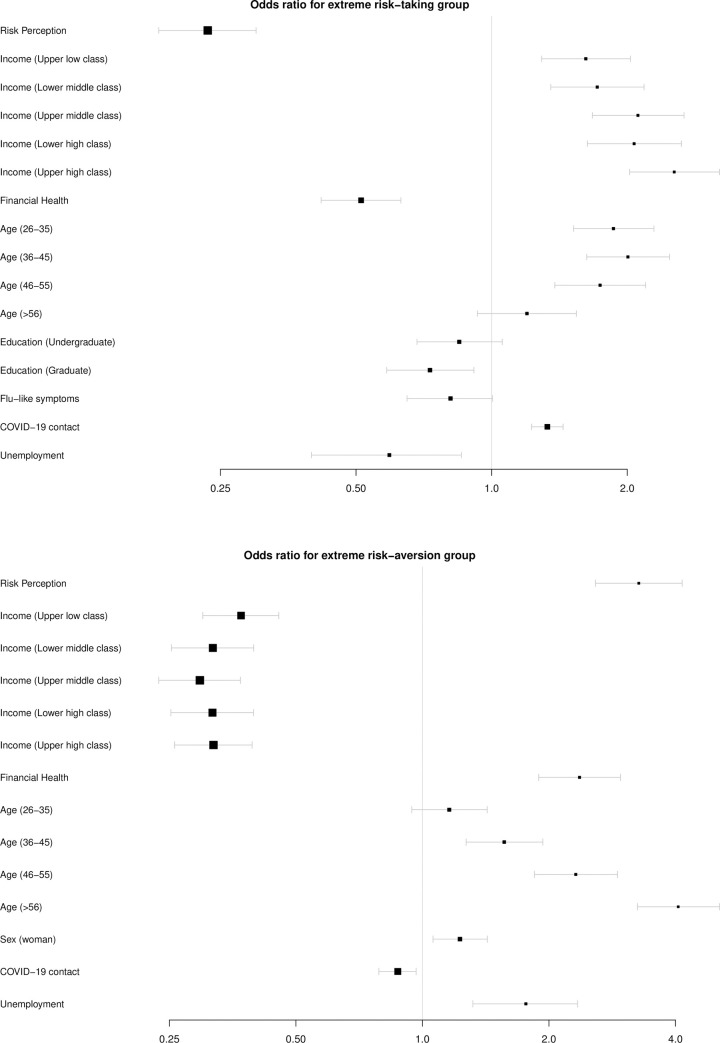
Odds ratio of the generalized linear model.Confidence intervals are set for 2.5% and 97.5%.